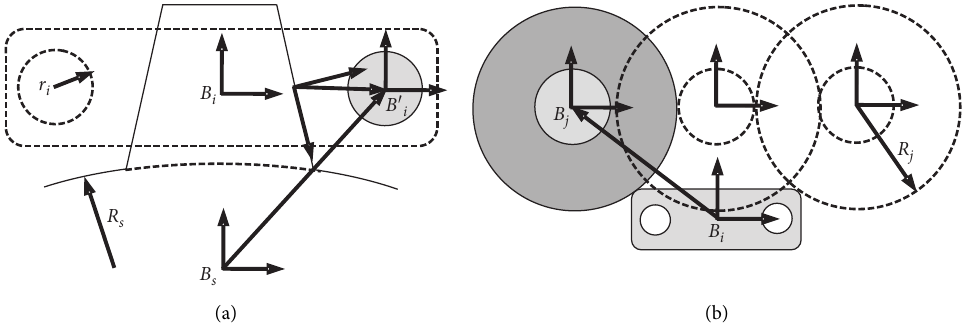
Figure 4: Two contact forms between track and wheels.